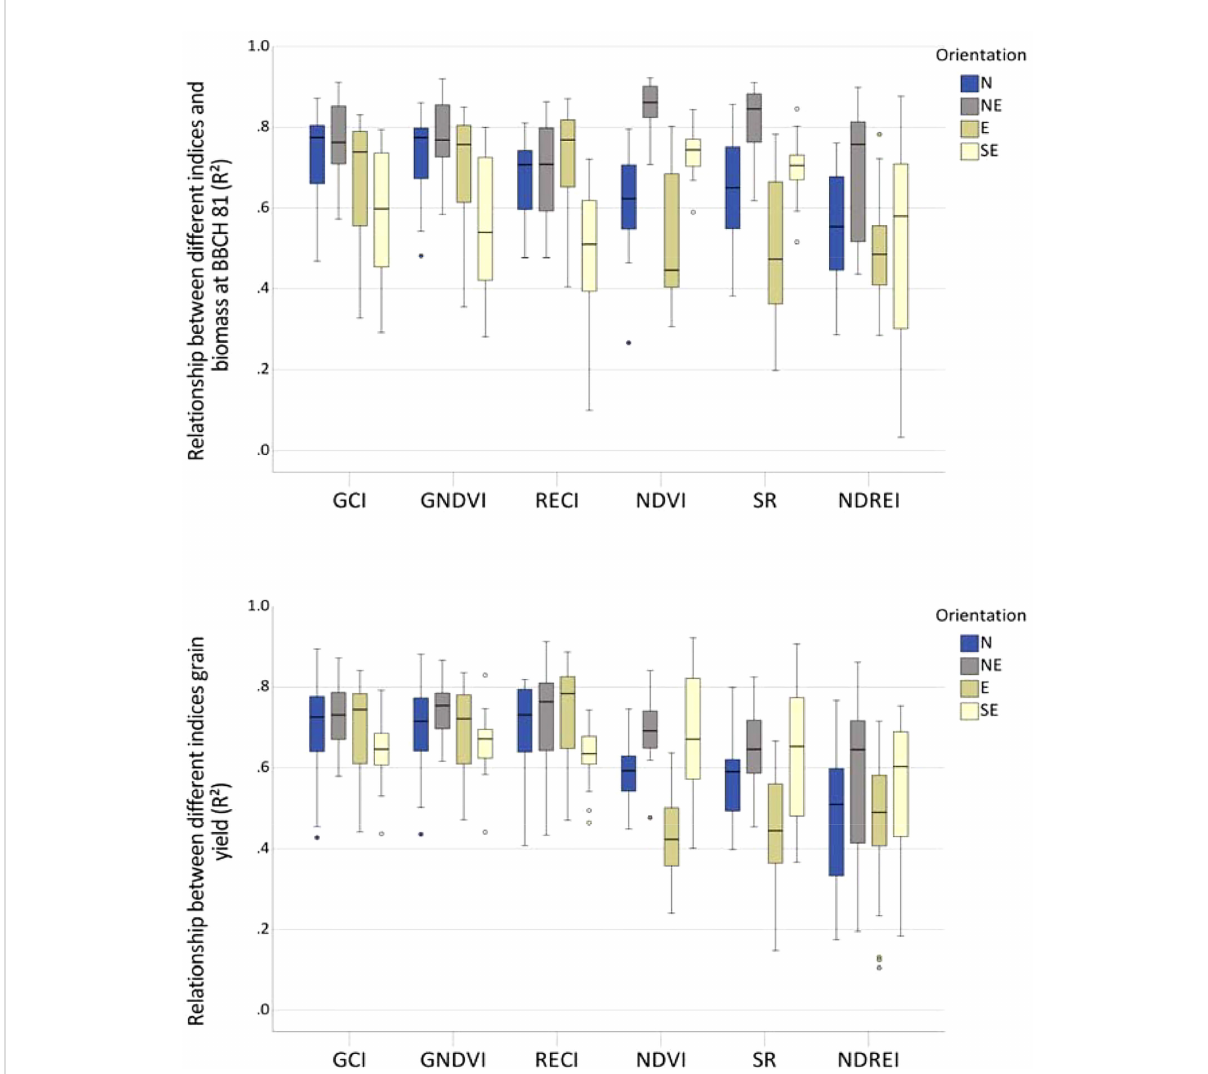
FIGURE 4 Boxplots depicting relationships between different indices and (A) biomass at BBCH 81 and (B) grain yield, in each row orientation, indicated as Pearson coef fi cients of determination across the